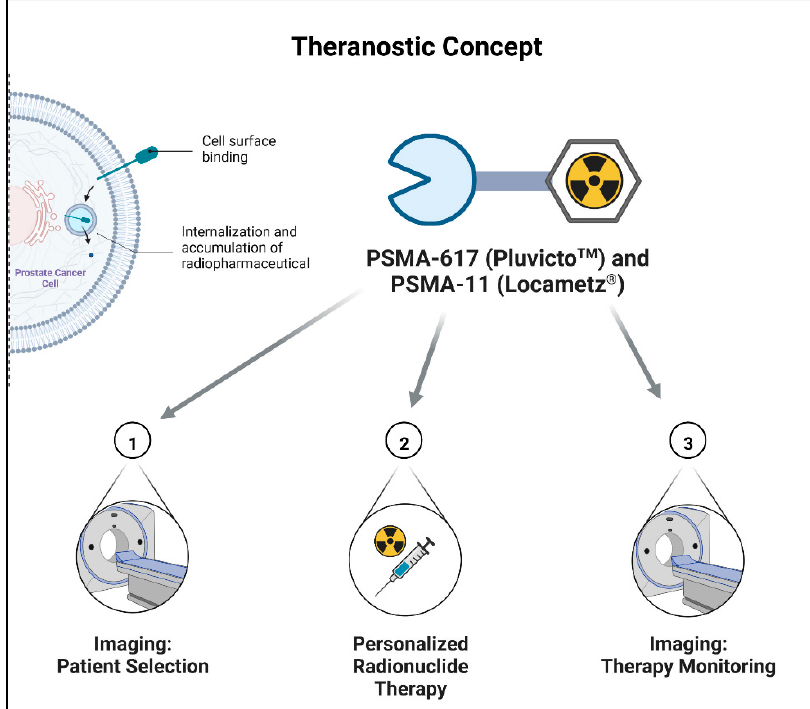
Figure 2. Theranostic concept.